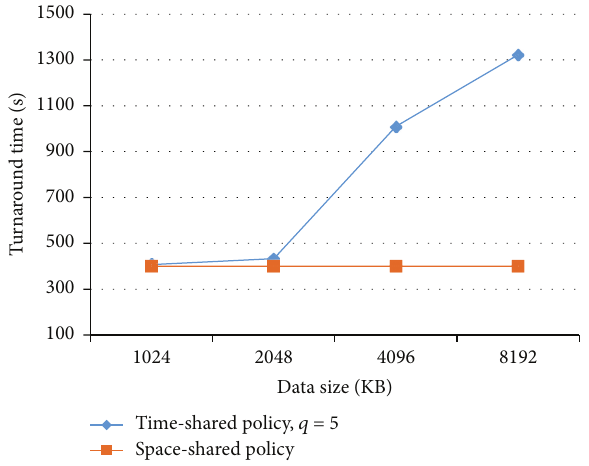
Figure 5: Turnaround time and data